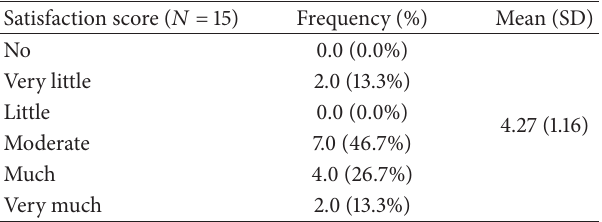
Table 4: Comparison between preoperative and 6-month postoper- ative 𝐾 values.